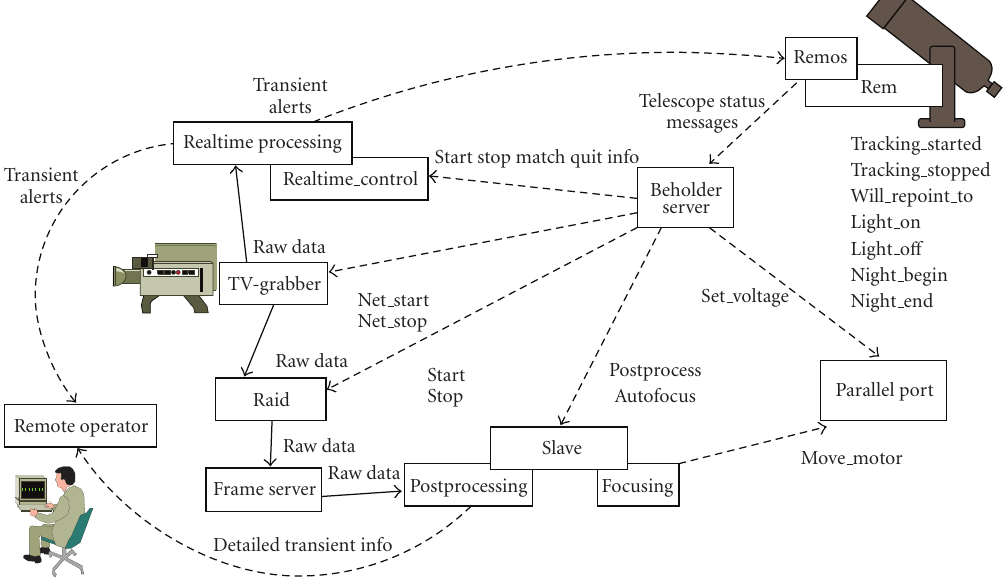
Figure 3: Schematic view of interoperation of various TORTORA subsystems with the REM telescope. The data are distributed from TV- CCD through the local Gigabit Ethernet network to a RAID array for a temporary storage and to a real-time processing software. All subsystems are controlled by a dedicated service connected to the REM operating software and responsible for the management of the image intensifier high voltage power supply, auto-focusing subsystem, and so